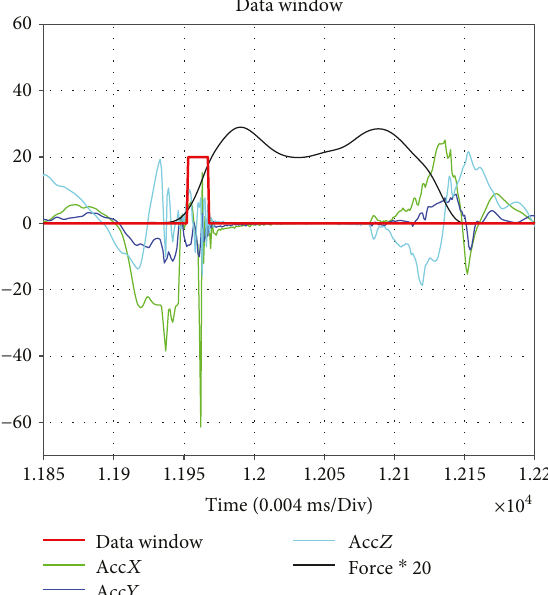
Figure 7: Data window for the feature extraction. The force multiplied by 20 is the aim for analyzing in the same magnitude.